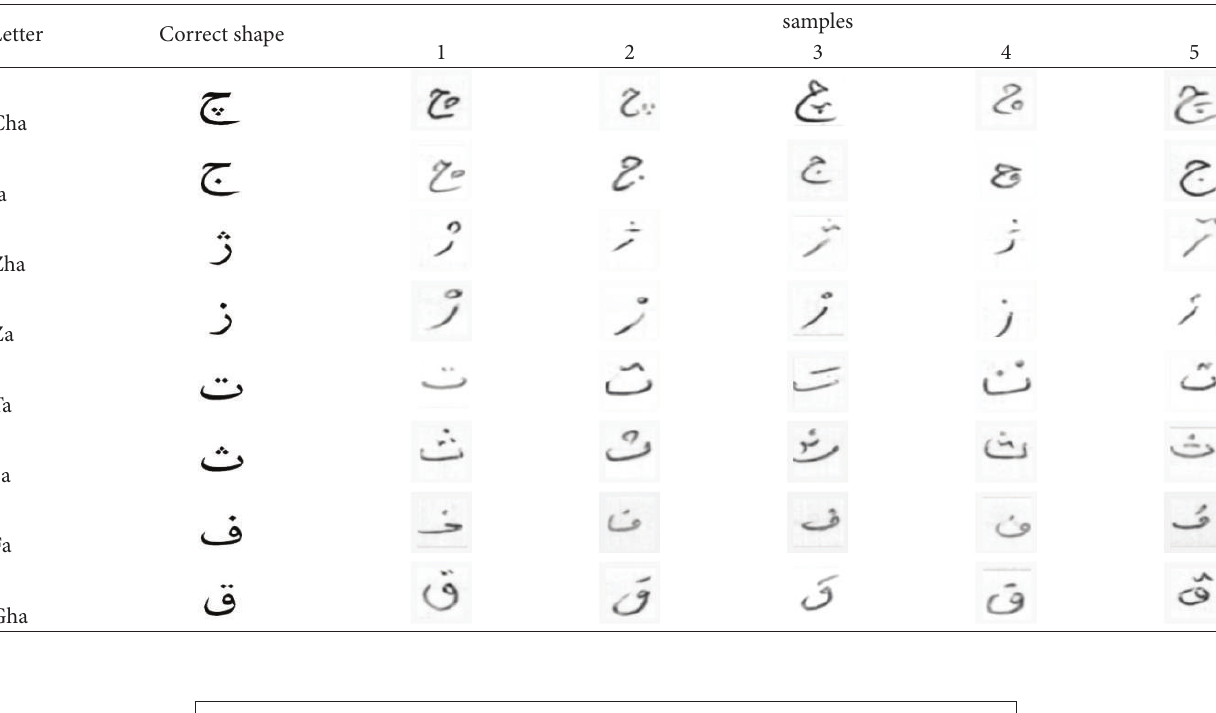
Table 4: Some samples of handwritten Persian letter